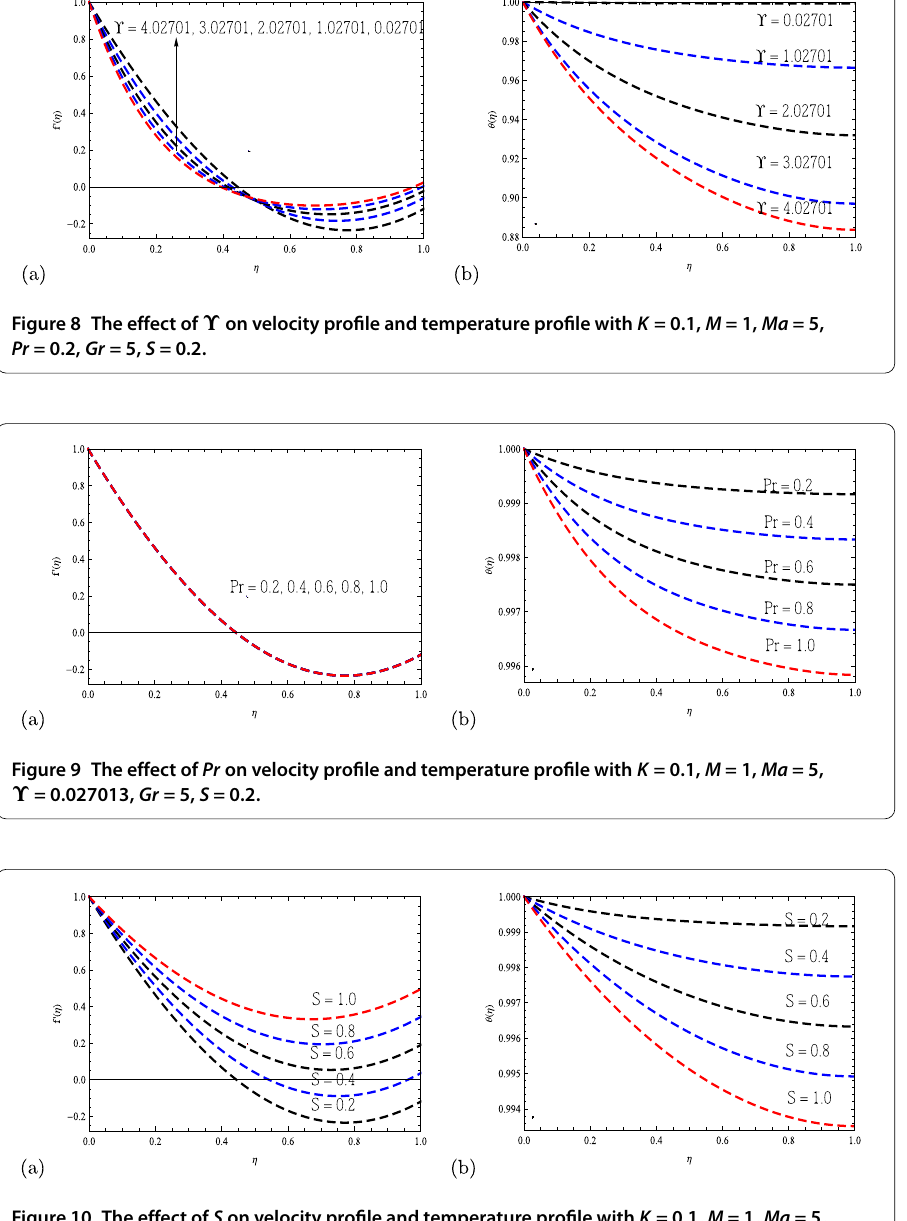
Figure 10 The effect of S on velocity profile and temperature profile with K = 0.1, M = 1, Ma = 5, ϒ = 0.027013, Pr = 0.2, Gr =